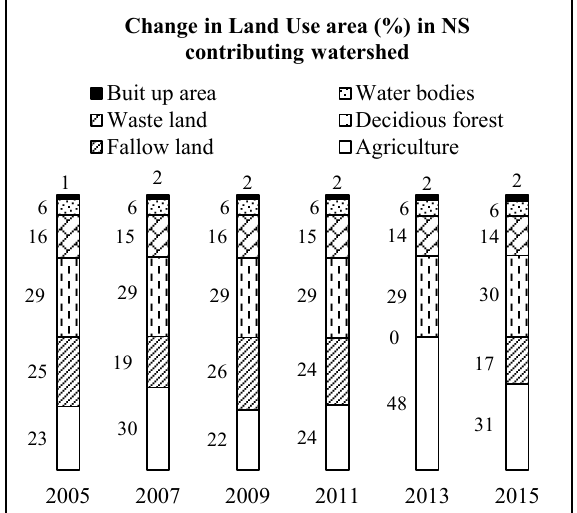
Figure 8: Shows the statistics related to the area (%) of the land use patterns in NS contributing watershed for every two years from 2005 to 2015.